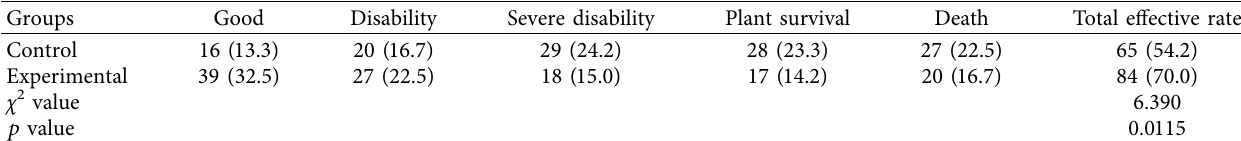
Table 6: Comparison of prognosis between the two groups ( n